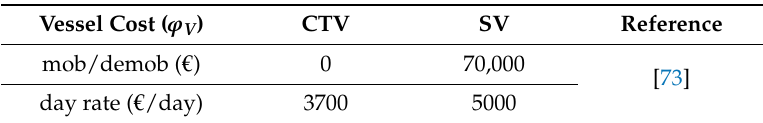
Table 10. Vessel